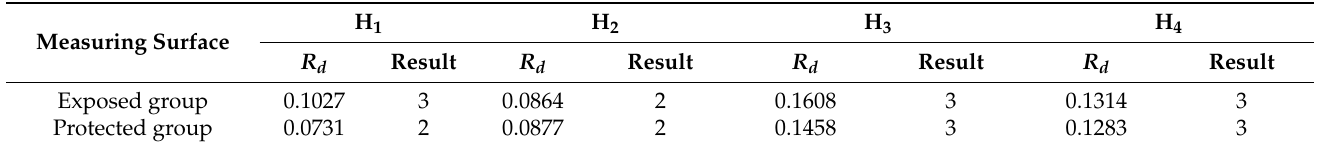
Table 8. The results of surface division.